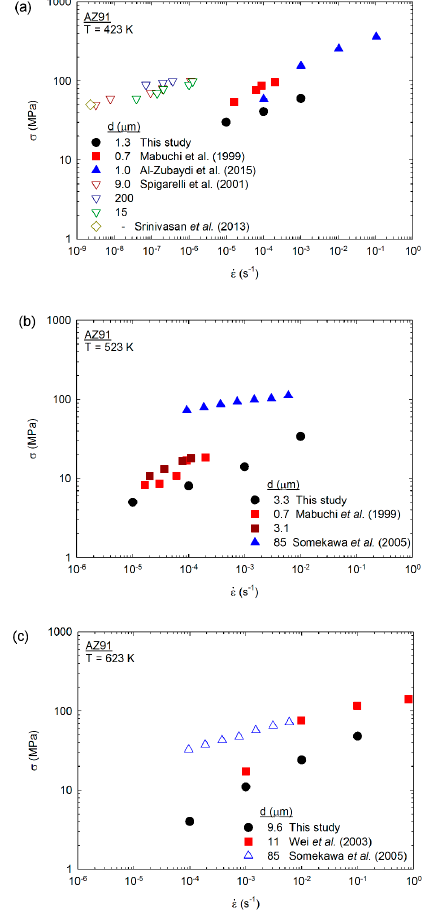
Figure 4. Plots of stress vs. strain rate for AZ91 alloy with different grain sizes and tested at ( a ) 423 K, ( b ) 523 K, and ( c ) 623 K. Data from the literature [14,37–41] were also included.